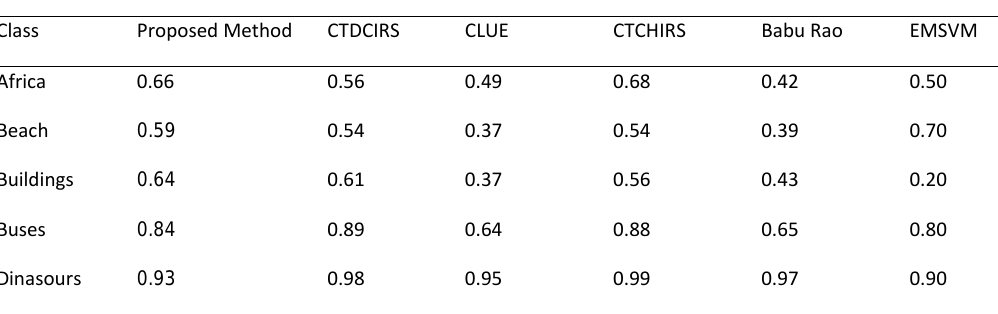
Table 1. Comparison of average precision obtained by proposed method with other standard retrieval systems [28, 6, 18, 29, 27]